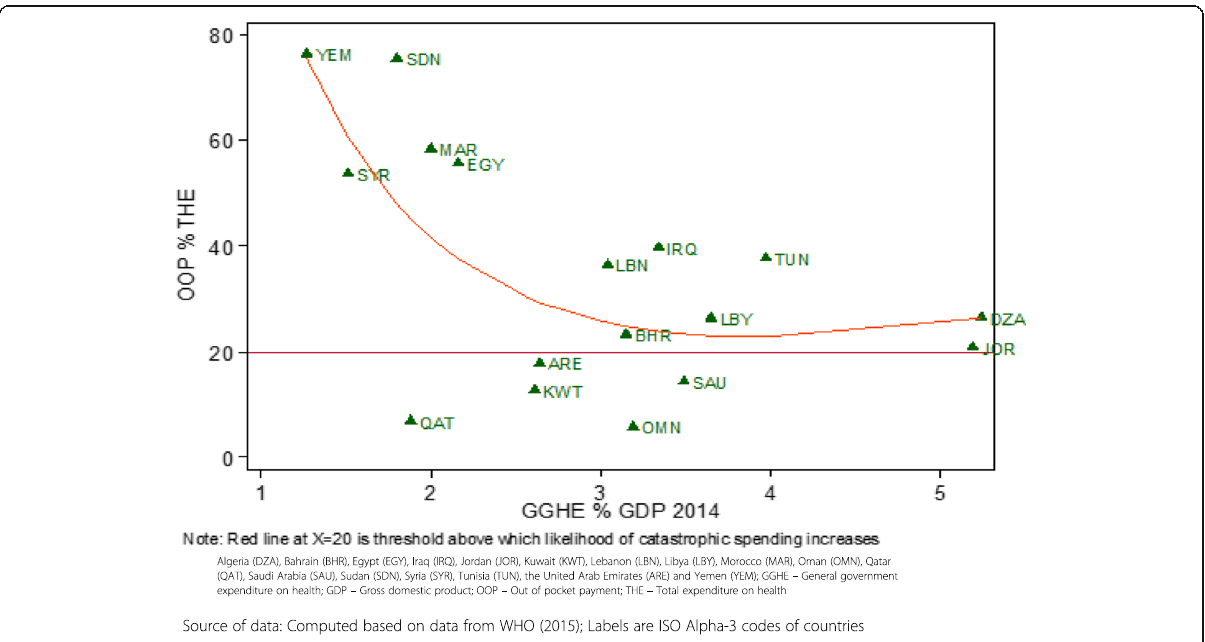
Fig. 4 General government expenditure on health as a percentage of gross domestic product vs. out of pocket spending as a percentage of total health expenditure, 2014